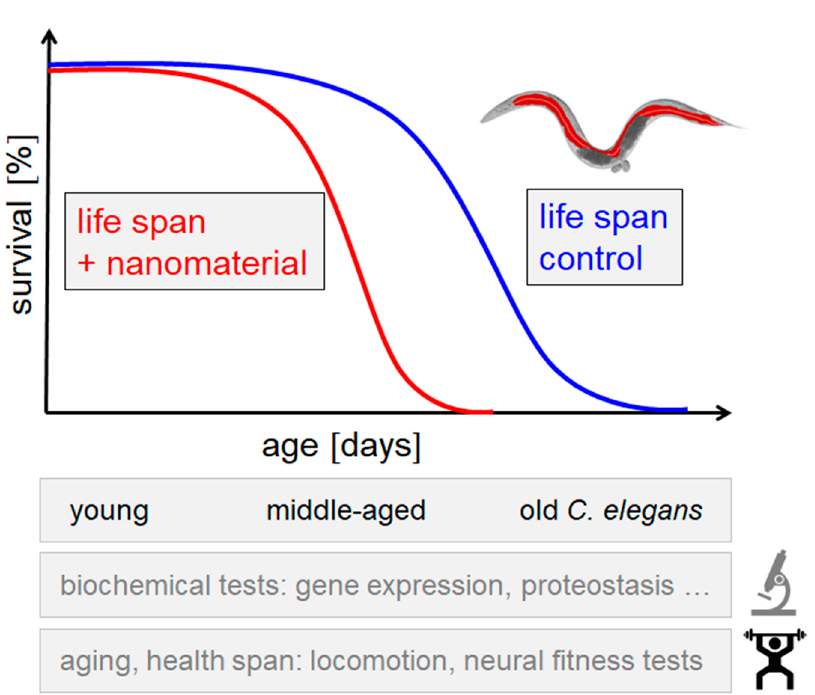
Figure 2. A combination of aging research and toxicology applies life span-resolved investigation of the biological response to nanomaterials. The life span can be determined in unexposed (life span control) vs. adult hermaphrodite C. elegans exposed to nanoparticles (+nanomaterial). Biochemical and behavioral analyses can be performed in young, middle-aged and old C. elegans .